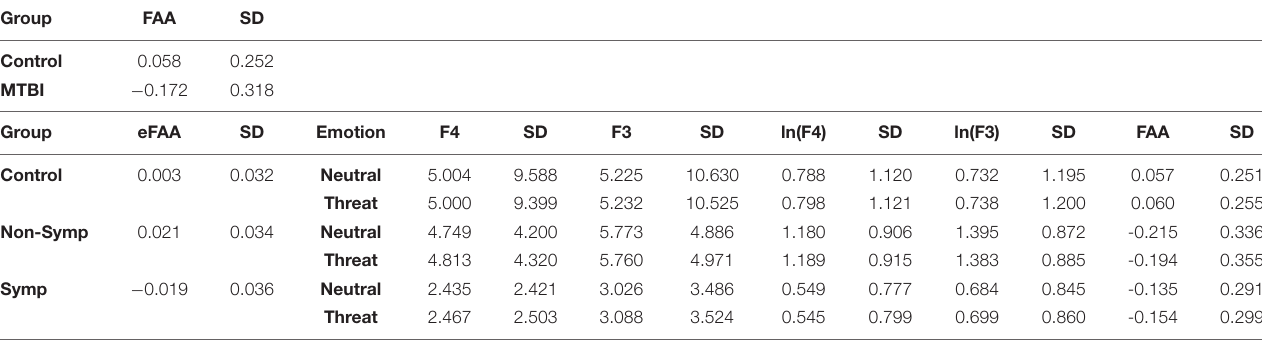
TABLE 1 | Average FAA, eFAA and alpha power ( µ V 2 /Hz) at F3 and F4 electrodes, the corresponding logarithms (ln) and standard deviation (SD) for each group and condition (neutral, threat). FAA differentiated MTBI group from the Control Group while eFAA differentiated the Symptomatic MTBI group from both the Non-symptomatic MTBI group and the Control Group. Non-Symp = Non-symptomatic MTBI group, Symp = Symptomatic MTBI group.